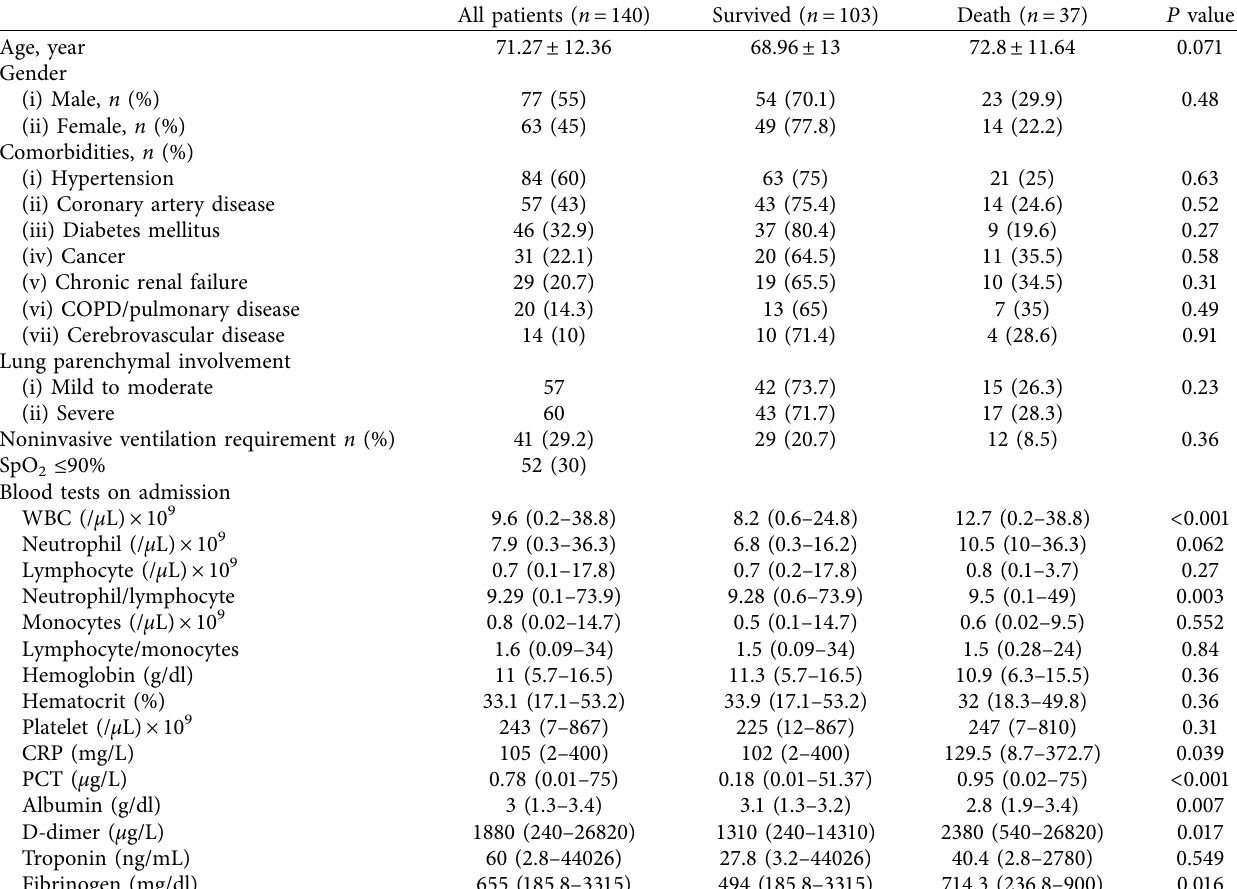
Table 1: Kaplan–Meier analysis parameters predicting IMCU